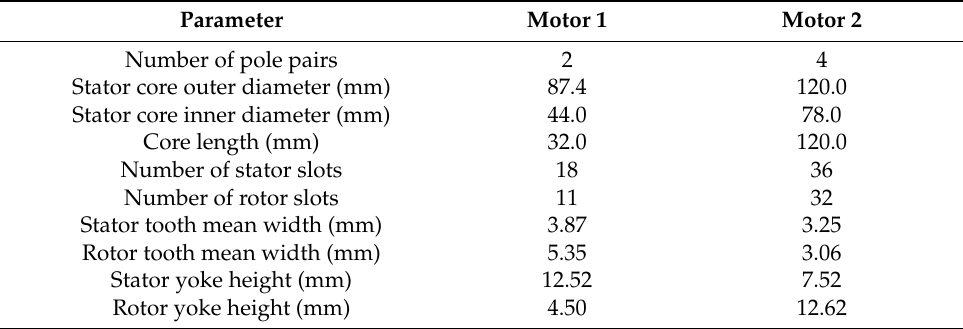
Table 1. Electromagnetic parameters of the investigated induction